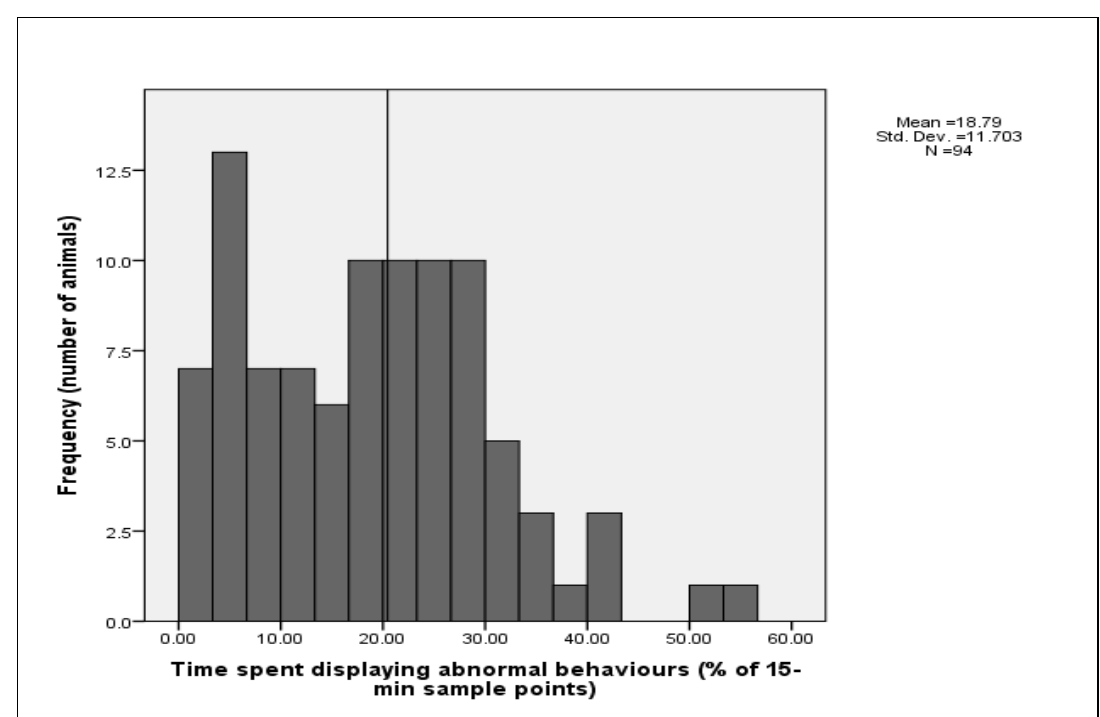
Figure 2. Histogram showing the distribution of time that sheep spent displaying abnormal behaviours (pacing and chewing and nosing pen fixtures) from 08:15–18:15 h over the two days of observations.